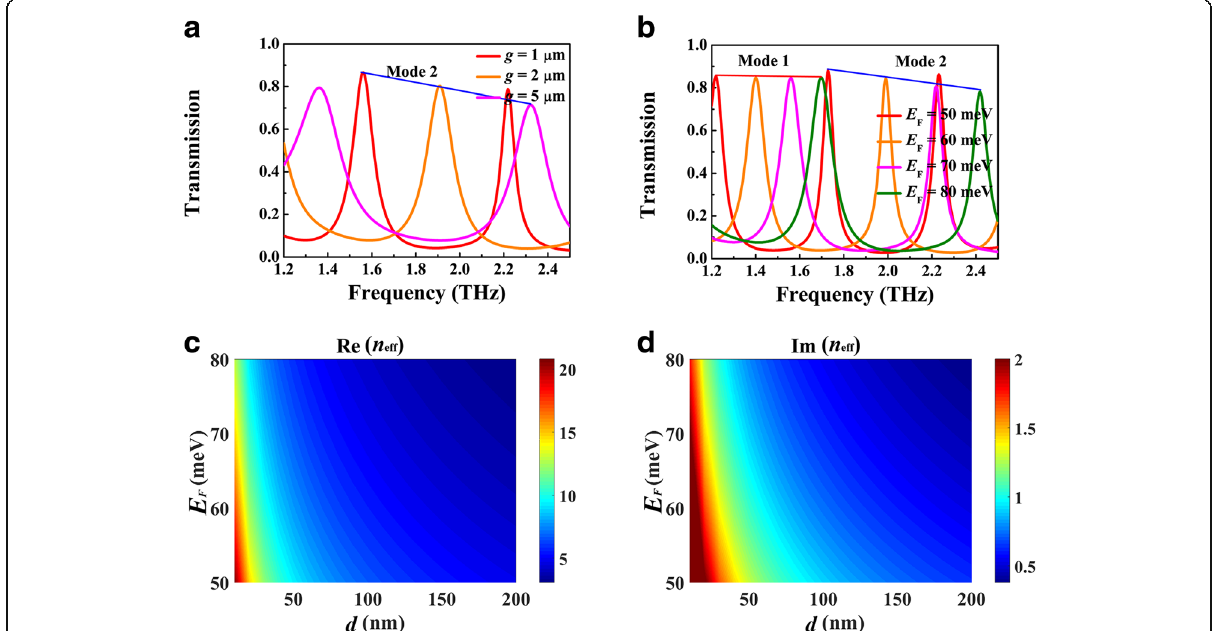
Fig. 6 Transmission spectra for different gap width g ( a ) and Fermi energy E F ( b ), where the other parameters are same as Fig. 4b. Dependence of Re( n eff ) ( c ) and Im( n eff ) ( d ) on the Fermi energy E F and gap width